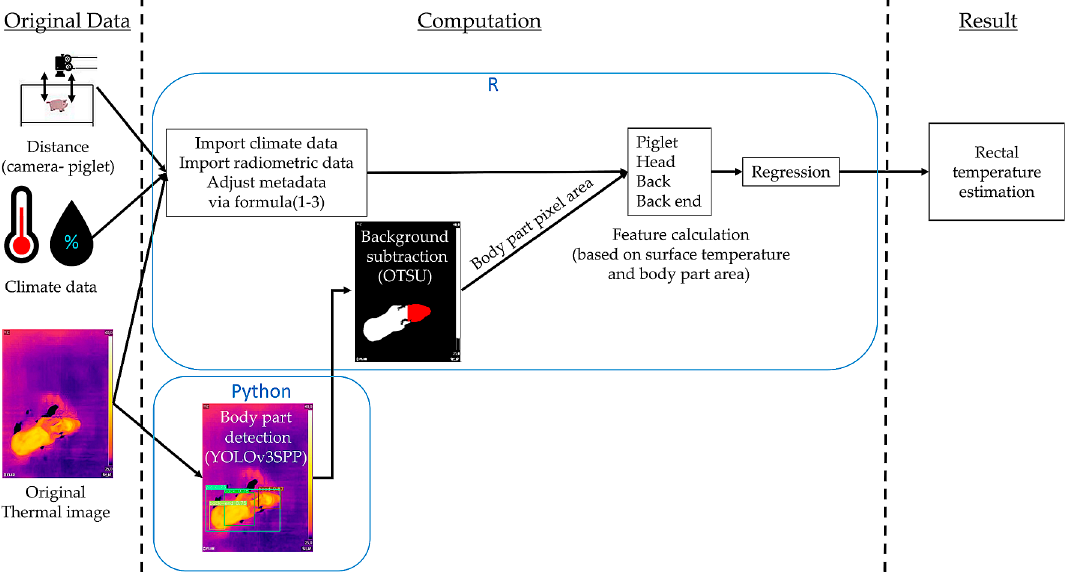
Figure 3. Workflow chart of the R package “ThermalPigR”. On the left is the original data from data acquisition. In the middle, the computation is performed by R and Python (object detection). After feature calculation the rectal temperature of the piglets is estimated (right